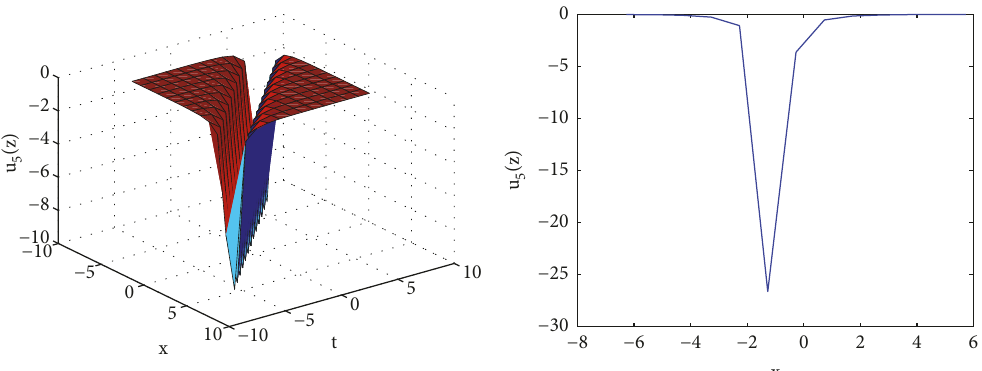
Figure 5: The 3D and 2D surfaces of 𝑢 5 (𝑧) by considering the values 𝛾 = 1 , 𝜇 = 0 , 𝑘 = 1 , 𝐿 = 1 , 𝜆 = −4 , 𝑦 = 0 , 𝑎 = 1 , and 𝑡 = 0 for the 2D